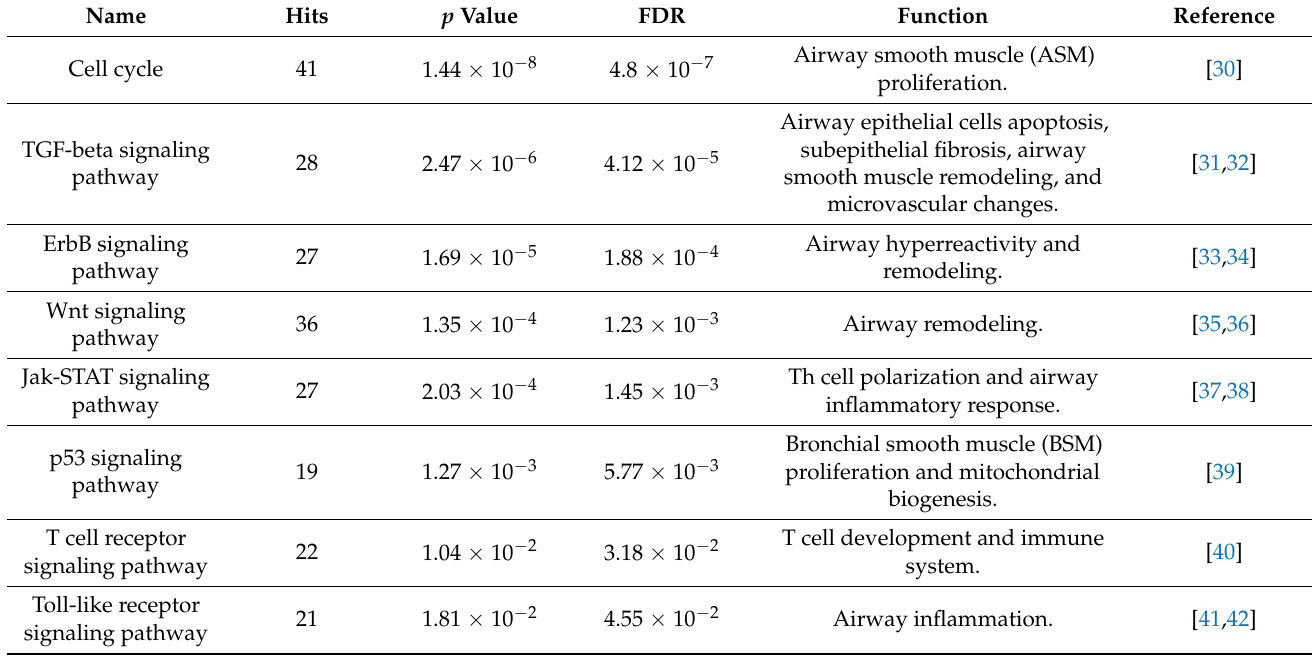
Table 4. Significant Kyoto Encyclopedia of Genes and Genomes (KEGG) signaling pathways in association with